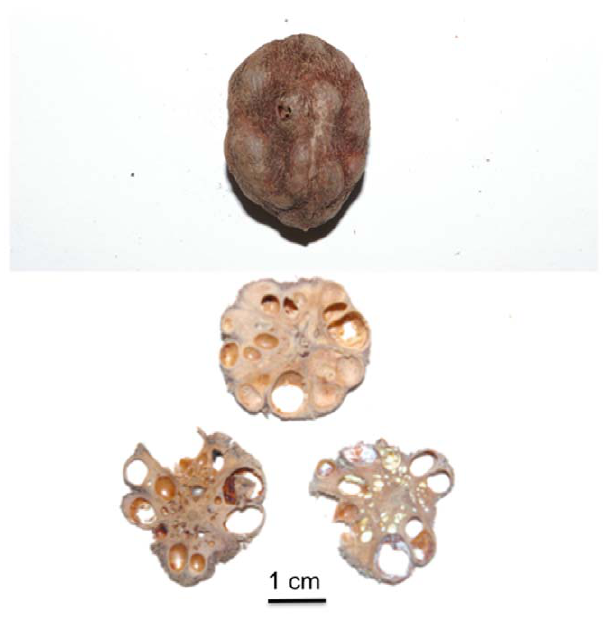
Figure 2. Seed casing of Sacoglottisgabonensis (top), and cross sections (bottom). Both the outer casing and the material comprising the inner compartments are hard, whereas the seeds found within the compartments (not pictured) are oily and relatively soft.